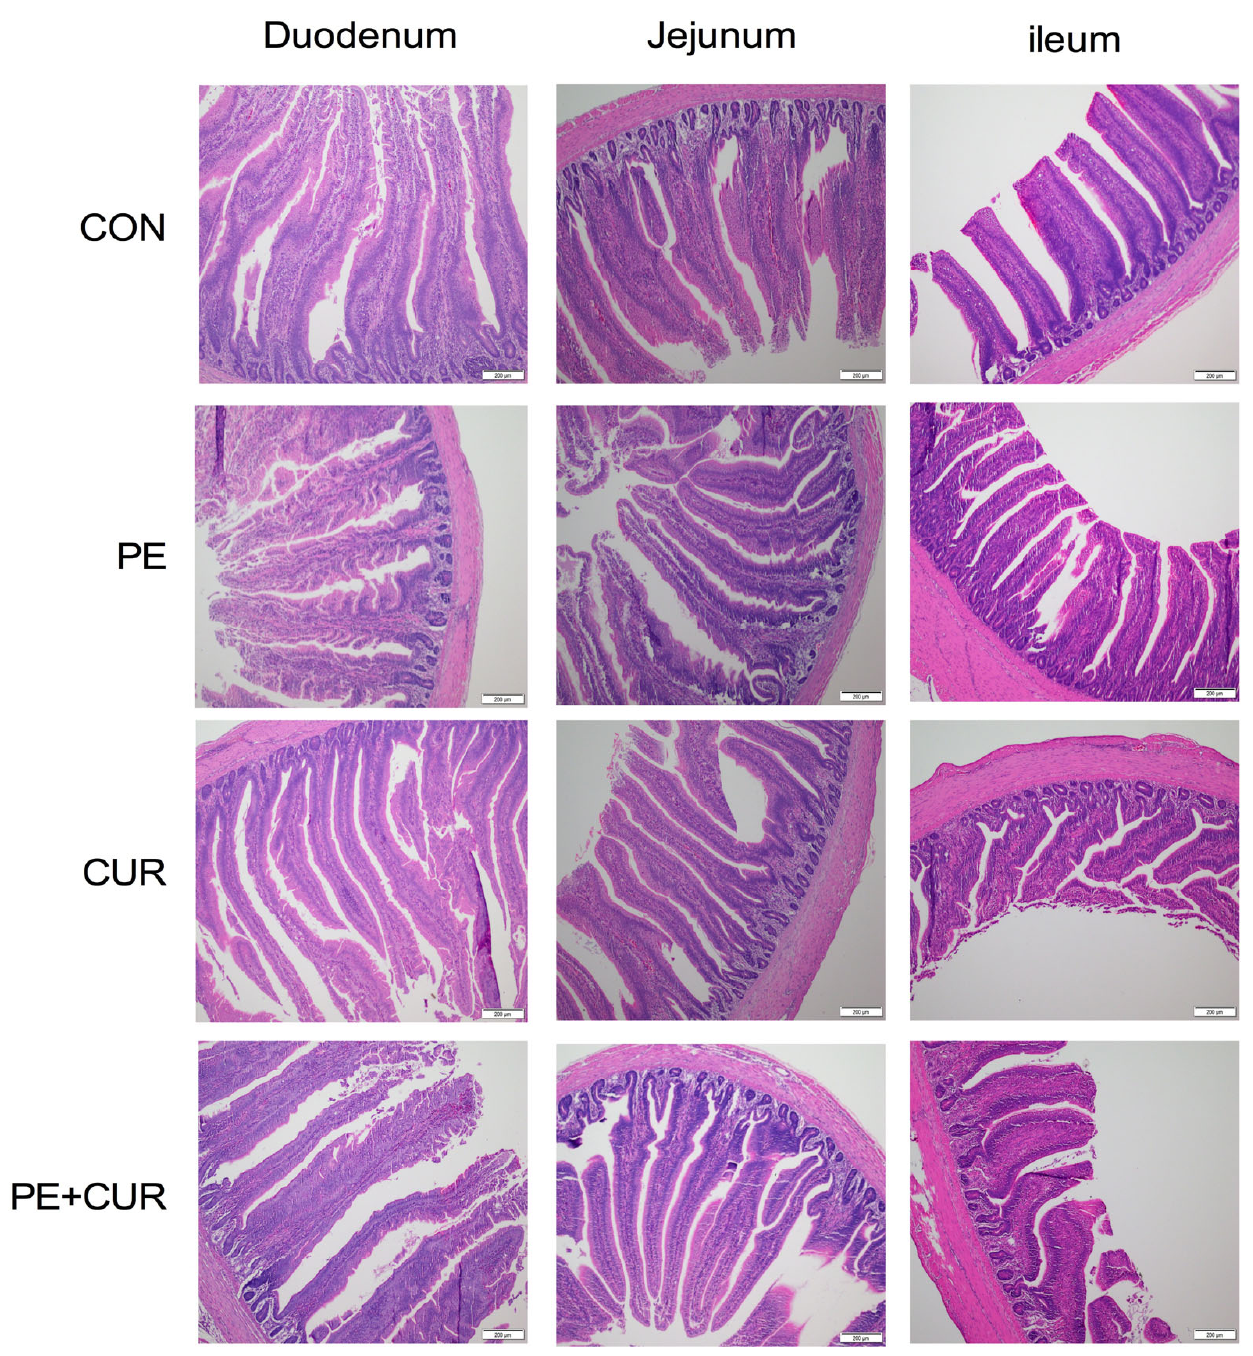
Figure 1. The images of intestinal morphology. CON: control; PE: pueraria extract; CUR: curcumin. Each image is magnified 100×. Table 6. Effects of dietary supplementation with PE and CUR on intestinal morphology of broilers 1 .